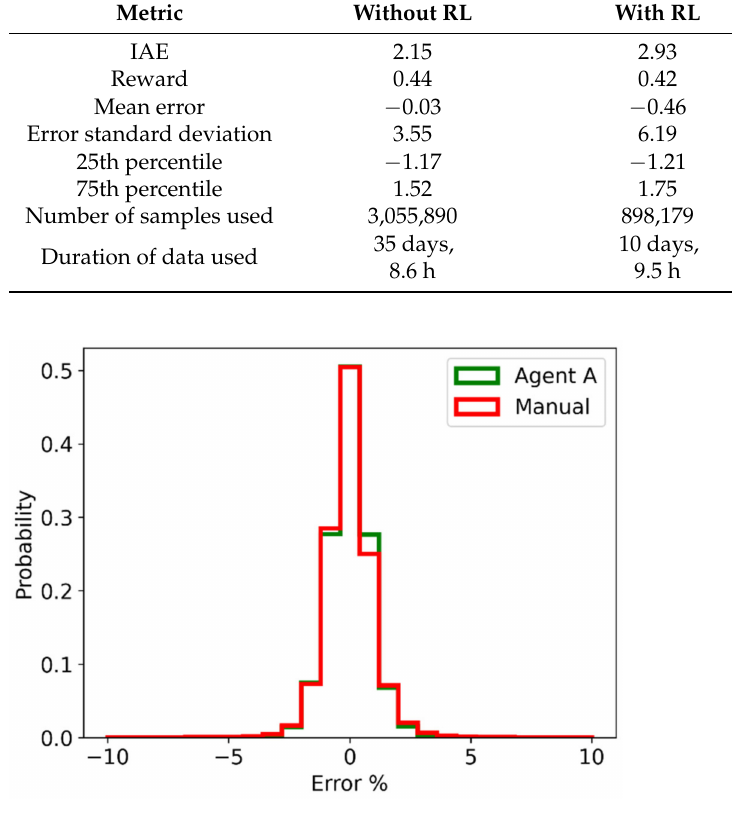
Figure 8. Mill inlet water control loop histogram of SV tracking error as a percentage of the